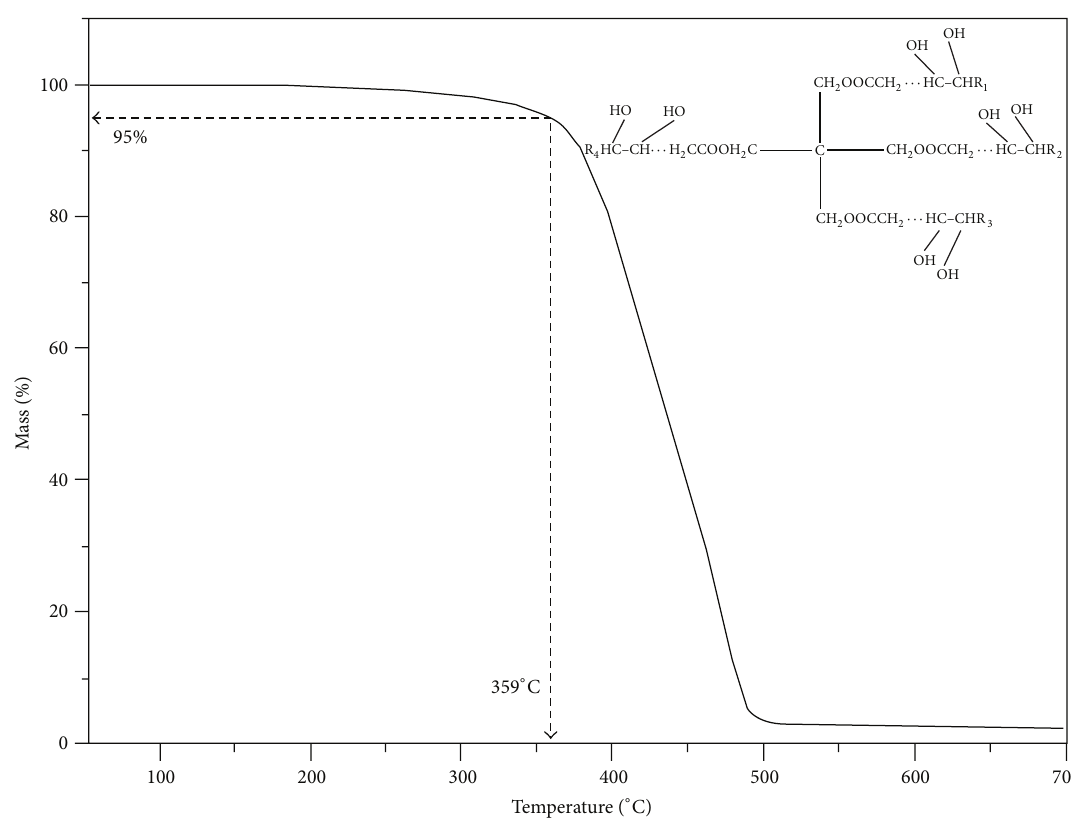
Figure 5: TGA thermogram of the